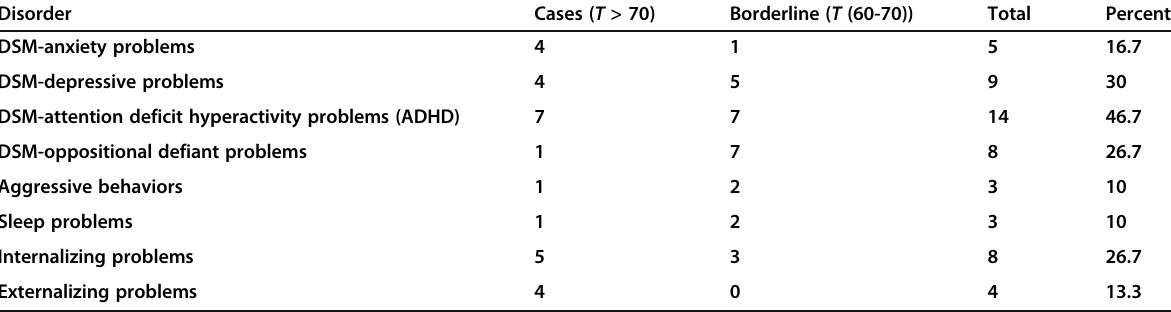
Table 1 Clinical characteristics of the study participants as diagnosed by CBCl a